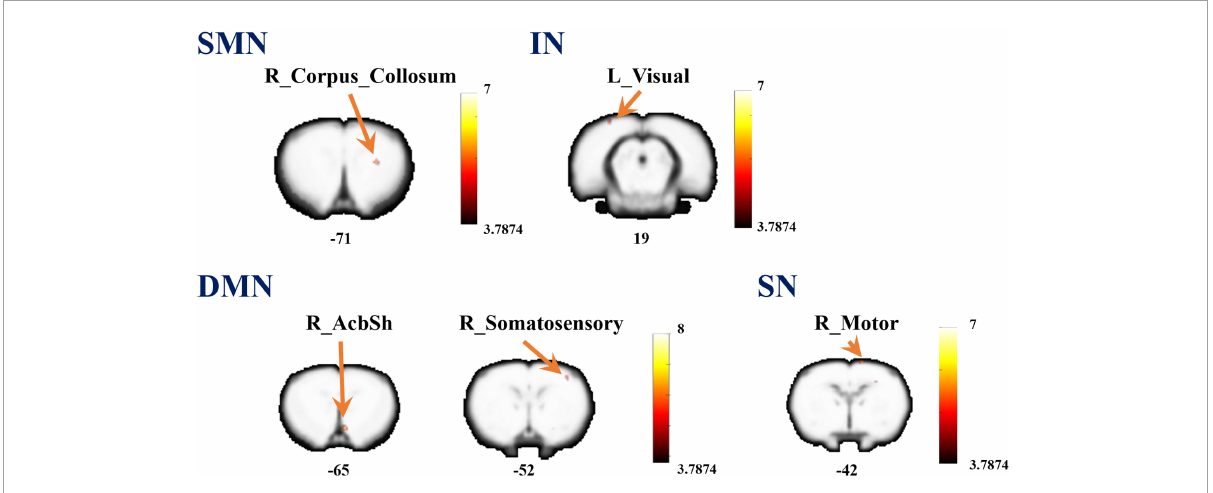
FIGURE5 A brain with altered function within the network between the MCAO/R group and MCAO/R + EA groups. Altered functional activity in the sensorimotor network (SMN), interoceptive network (IN), default mode network (DMN), and salience network (SN). Warm colors denote higher functional activity in the MCAO/R + EA group compared with the MCAO/R group, and cool colors denotes lower functional activity in the MCAO/R + EA group. Two sample t -test ( P = 0.001, alphasim corrected, cluster size > 10).